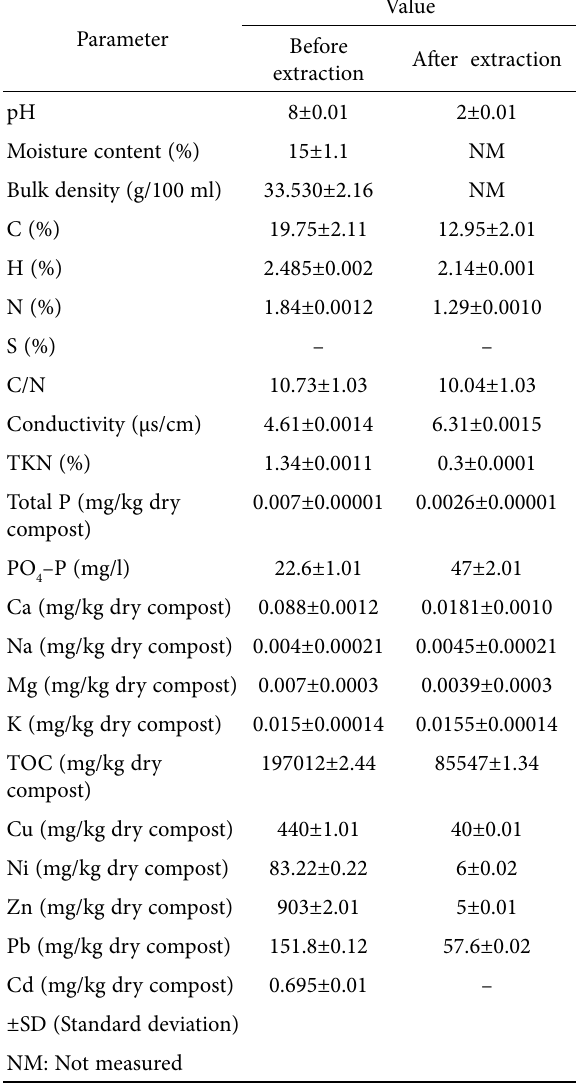
Table 3. Characterization of compost samples (Ozbas 2008;